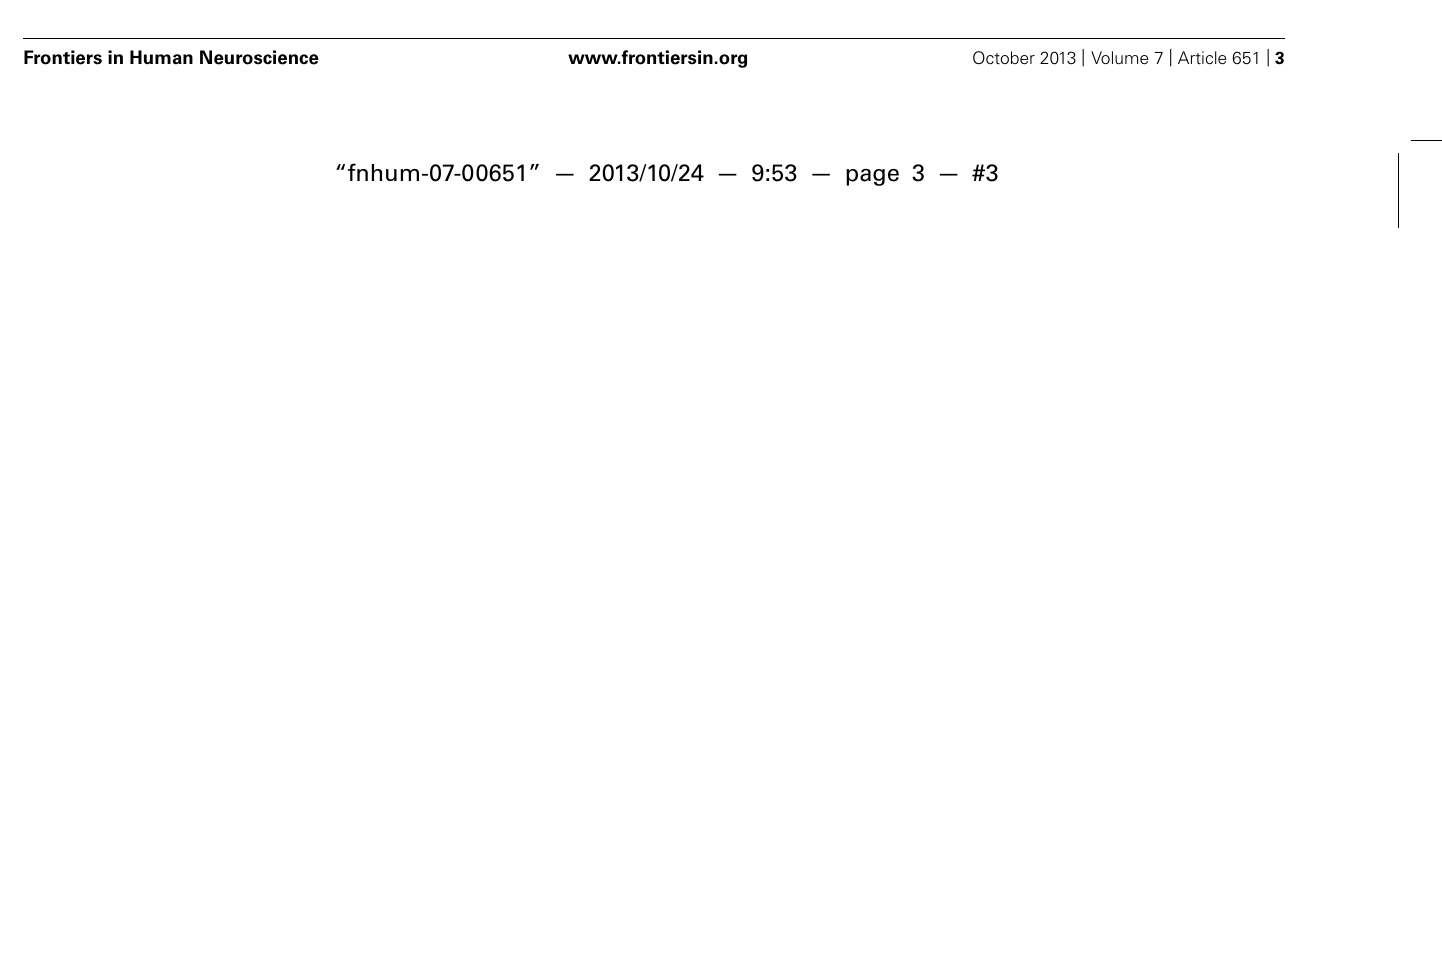
FIGURE 1 | (A) Trial structure of the flanker task in experiment 1. A central fixation dot was presented for 1000 ms, followed by an arrow array for 100 ms. Afterward the central fixation dot was presented again for 900 ms. Responses could be conducted after stimulus onset and before the onset of the first fixation cross (response window = 1000 ms). (B) Schematic